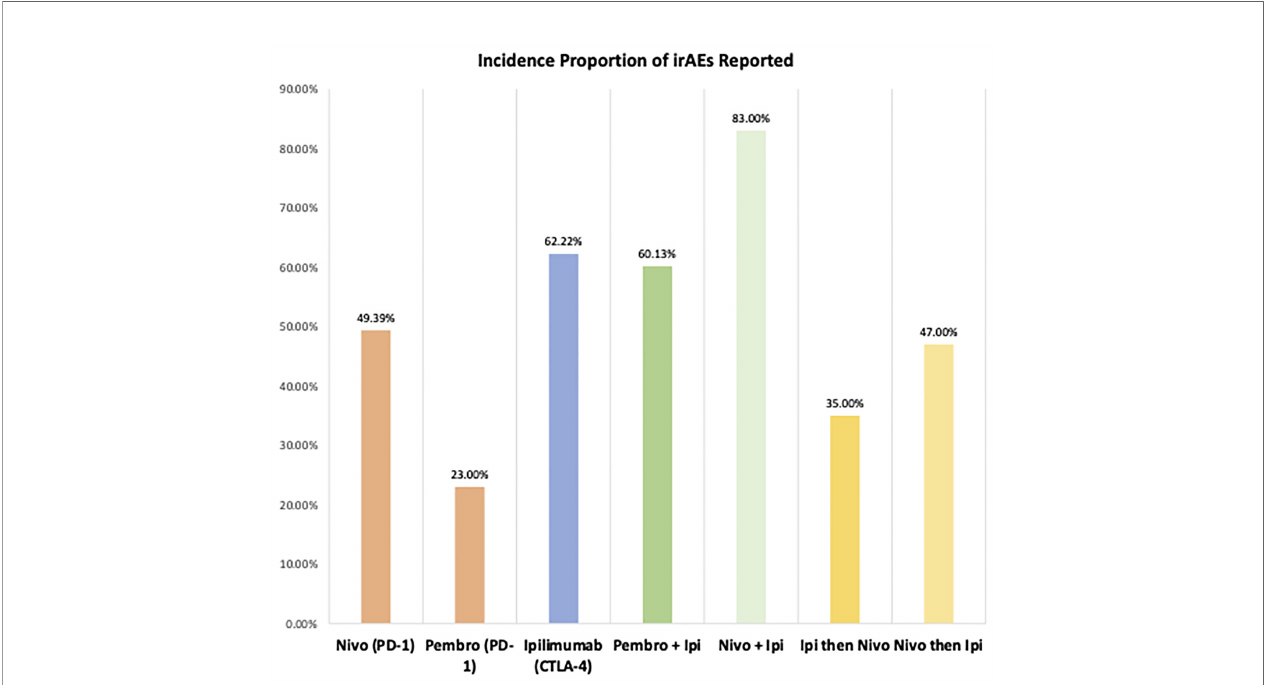
FIGURE 2 | Proportion Incidence of All IrAEs by Mono/Dual-IO Agents Cohorts Using Data from Advanced Melanoma IO Trials. Proportion of all irAEs (Grade 3 or less) incidence amongst 9 major advanced melanoma RCTs using ICIs organized by mono/dual therapy studied. IO, Immuno-Oncologic Therapy; RCT, Randomized Control Trial; irAE, Immune-related adverse event; ICI, Immune-checkpoint Inhibitor; Pembro, pembrolizumab; Nivo, nivolumab; Ipi, ipilimumab; PD-1, Programmed Death Receptor-1; PD-L1, Programmed Death Receptor Ligand-1.